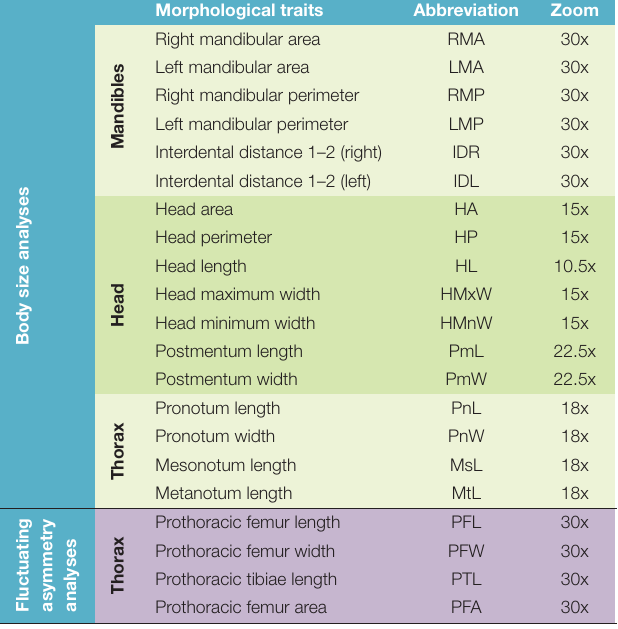
TABLE 1 | Morphological traits used to evaluate body size and fluctuating asymmetry in soldiers of N. chilensis from unicolonial and multicolonial substrates. Morphological